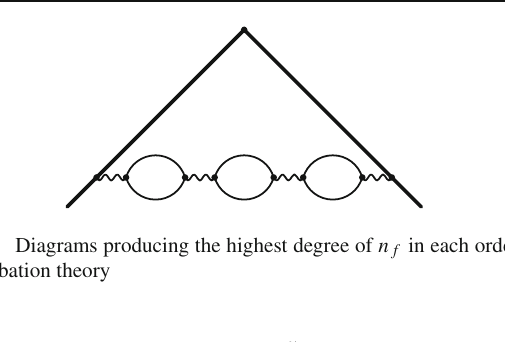
˜ Z does not depend on the